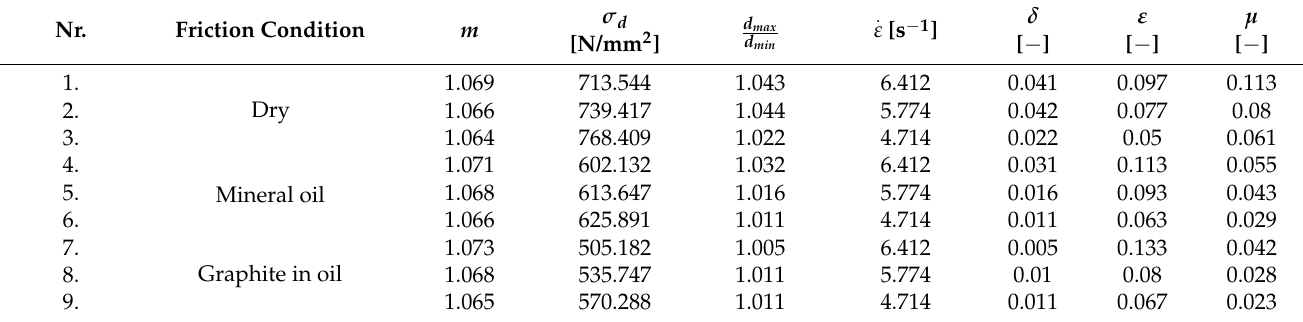
Table 4. Experimental results for different friction